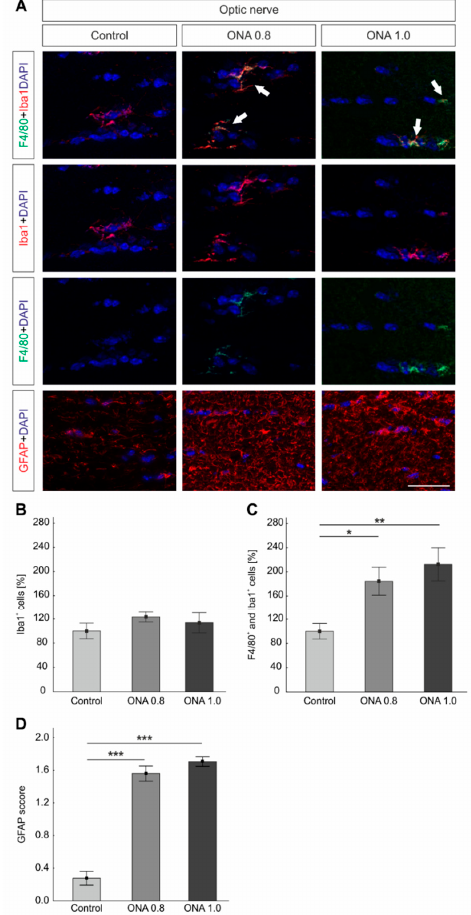
Figure 6. Enhanced glia cells in the optic nerve. ( A ) The total number of microglia was labeled with anti-Iba1 (red) and active microglia in combination with anti-F4 / 80 (green). Astrocytes were stained with anti-GFAP (red). Cell nuclei were marked in blue. Arrows pointed towards co-labeling of Iba1 + and F4 / 80 + cells. ( B ) No changes were noted in the number of Iba1 + cells in both immunized groups compared to controls ( p > 0.05). ( C ) Regarding activated microglia, significantly more F4 / 80 + and Iba1 + cells were noted in the ONA 0.8 ( p = 0.04) and ONA 1.0 optic nerves ( p = 0.006) compared to controls. ( D ) The GFAP score was significantly higher in the ONA 0.8 as well as in the ONA 1.0 optic nerves (both: p < 0.001). Values are mean ± SEM. Scale bar: 20 µ m. * p < 0.05, ** p < 0.01, *** p <